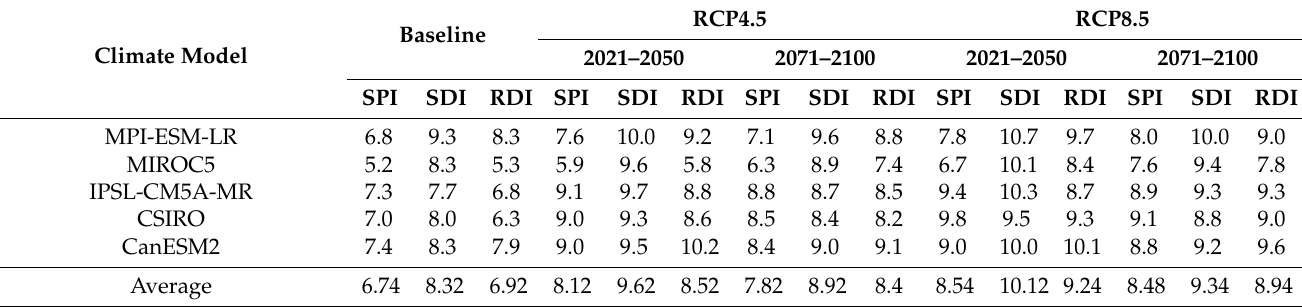
Table 2. Average drought durations of months for the Bilate watershed (SPI, SDI, and RDI < −